Question: Describe this figure in one sentence.
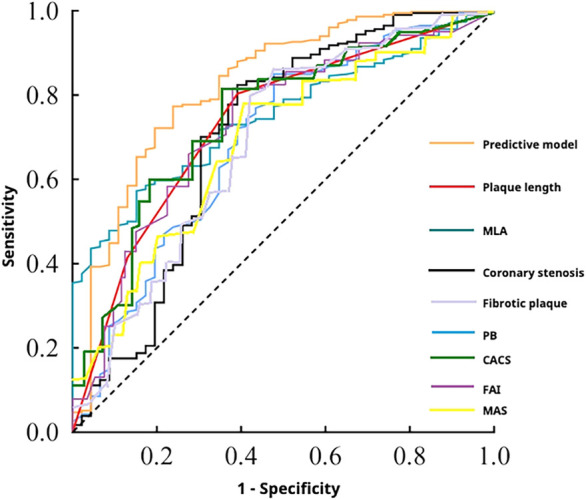
Answer: ROC curves of individual predictors and the combined prediction model for MACE in the derivation cohort.